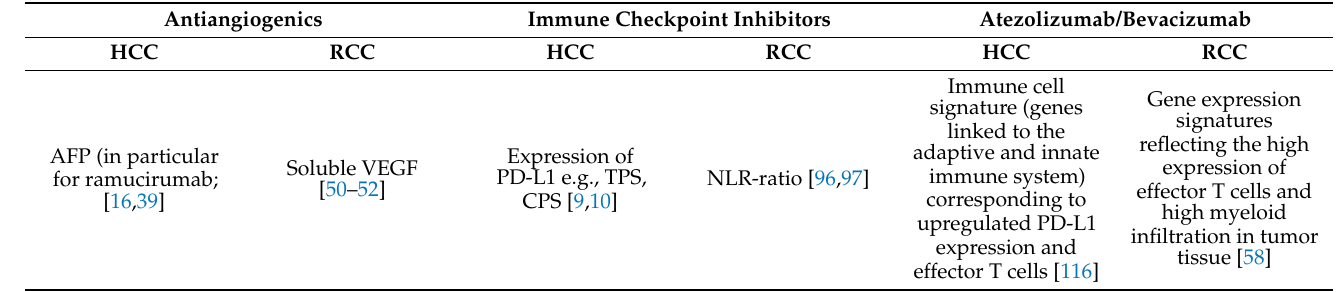
Table 1. Candidate biomarkers in HCC and RCC. AFP: alpha-fetoprotein; VEGF-A: vascular endothelial growth factor-A; Ang2: angiopoietin-2; SNP: single nucleotide polymorphism; VEGFR: vascular endothe- lial growth factor receptor; KDR: kinase insert domain receptor; PD-(L): programmed